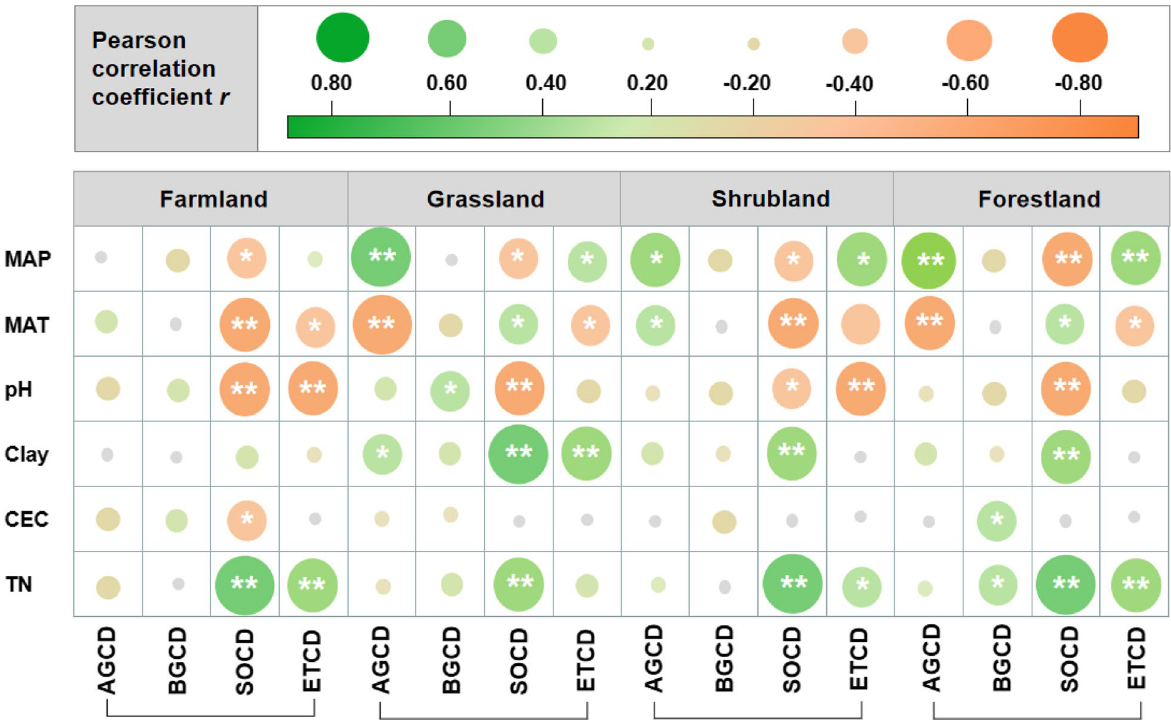
Fig. 6 Pearson correlation between C density and climate factors and soil properties for four ecosystem types. The color of each roundness is proportional to the value of Pearson’s correlation coefficient. Green indicates a positive correlation (dark green, r correlation (dark orange, r 0.80). * p < 0.05; ** p < 0.01. AGCD: above-ground carbon density; BGCD: above-ground carbon density; SOCD: soil = organic carbon density; ETCD: ecosystem total carbon density; MAP: mean annual precipitation; MAT: mean annual temperature; pH: soil pH; TN: